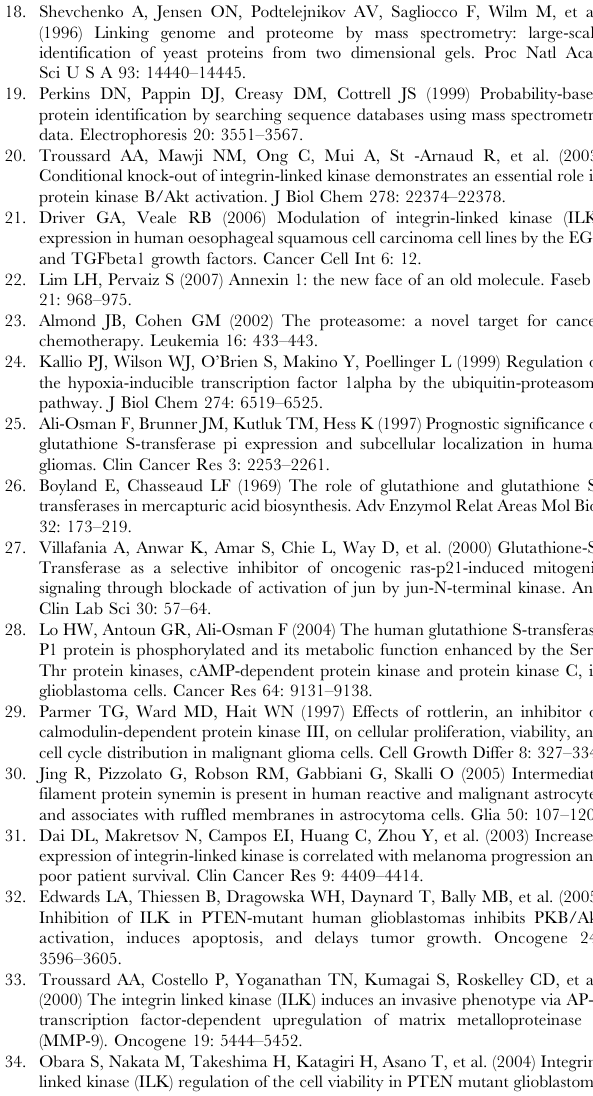
Table S1 Proteomic analysis scheme.